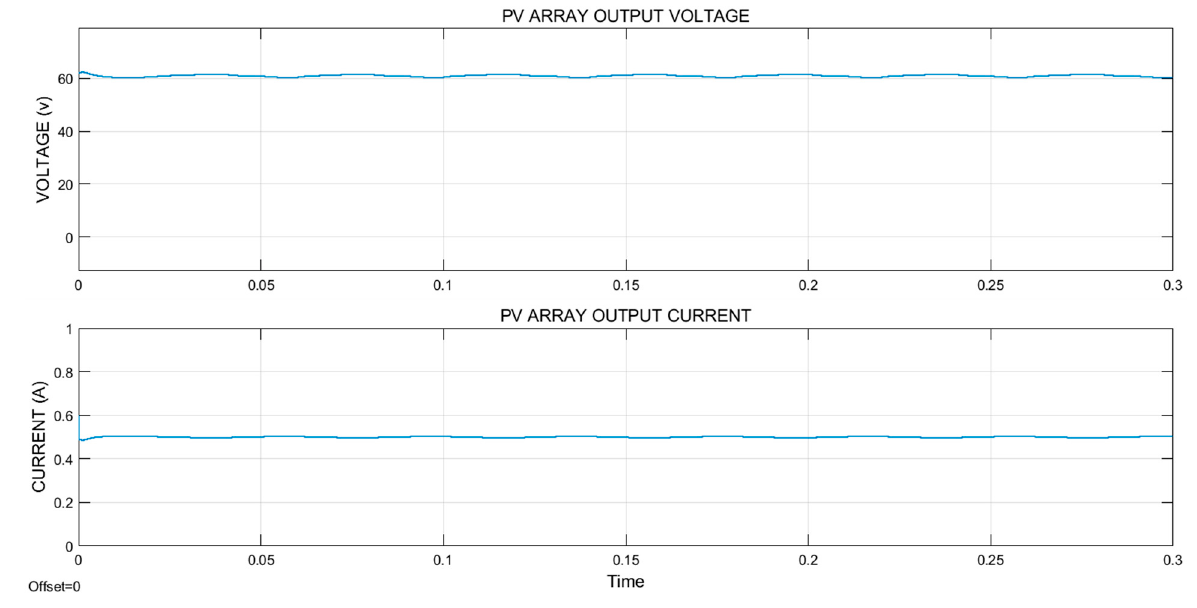
Figure 17. PV array output voltage and current.